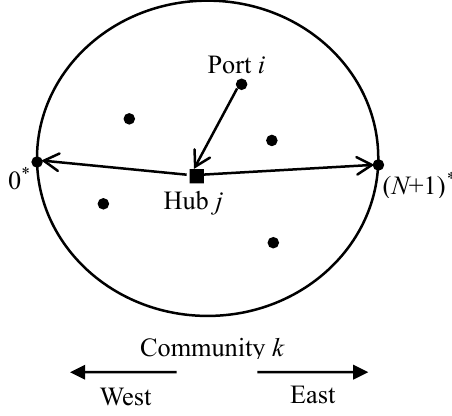
Figure 1. The container routing within a community.